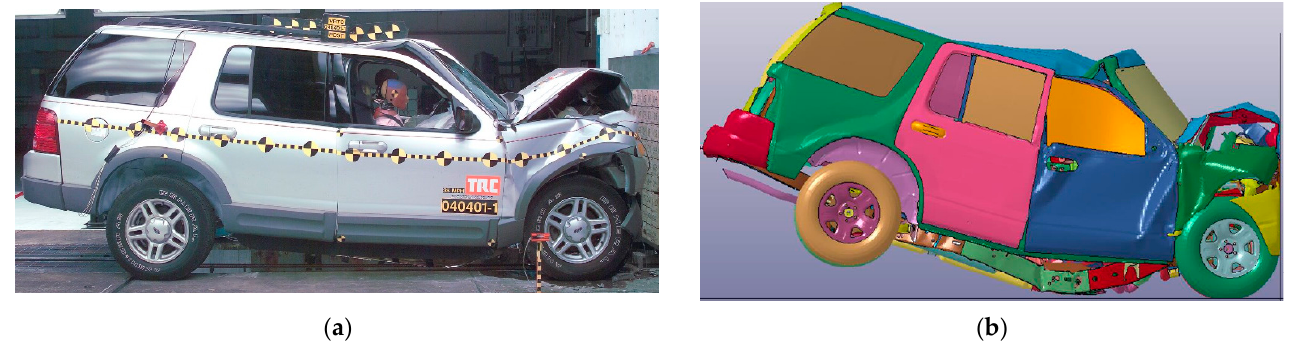
Figure 15. Similarity of the crash test in a frontal collision of the original SUV [23] versus the virtual armored model: ( a ) original SUV; ( b ) virtual armored model.